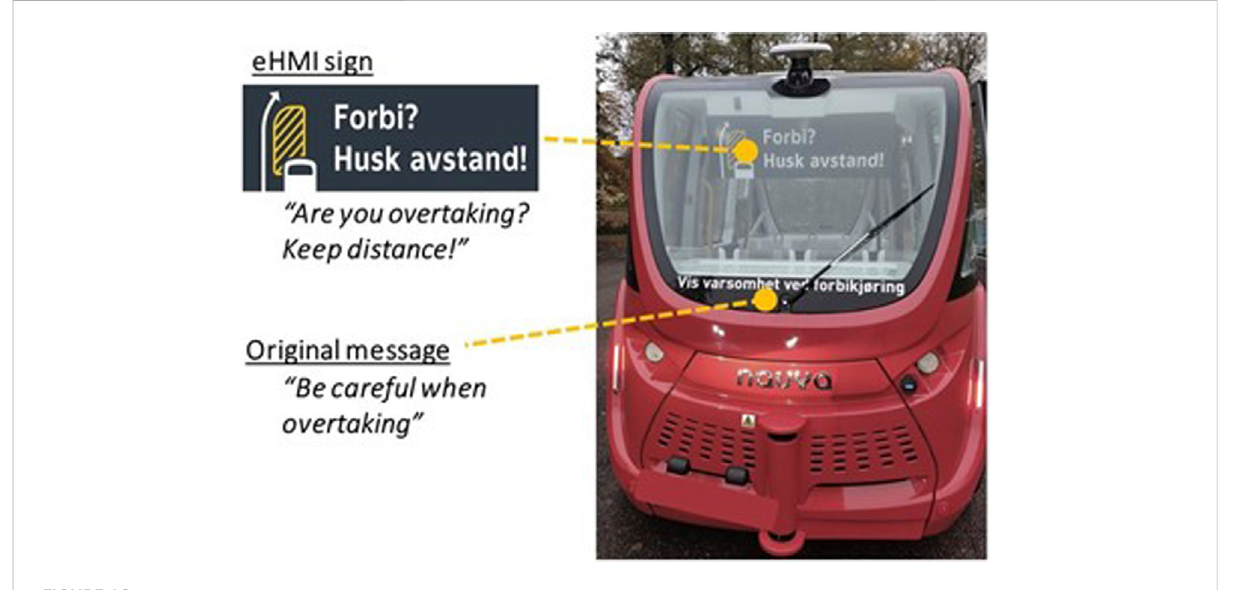
FIGURE 16 One of the shuttles that roamed Oslo showing the overtaking